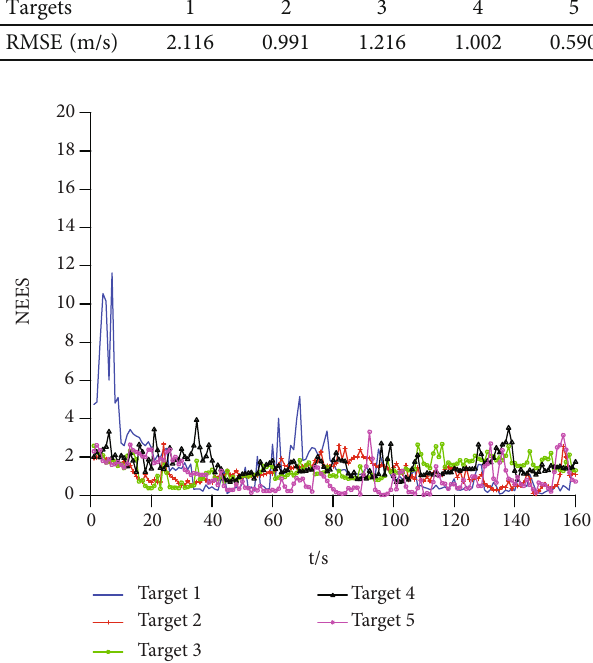
Figure 8: The average NEES versus time scans for fi ve